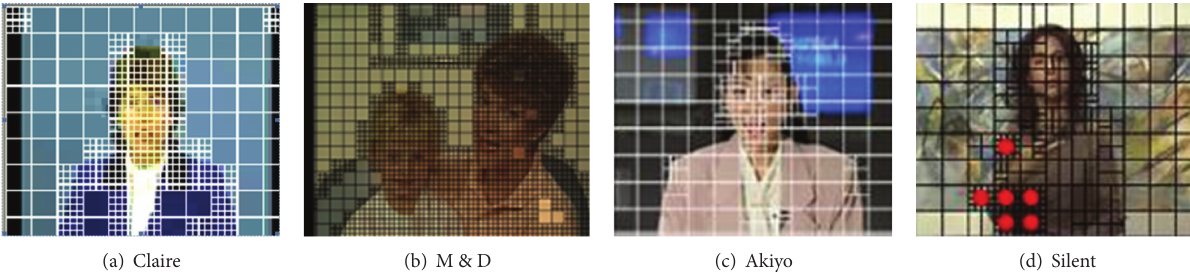
in P-frame coding or uses Intra 4 × 4 in I-frame coding, then the current encoding block has abundance of texture feature or changes in spatial domain, the current block belongs to attention region, the spatial saliency is high, and then it can be expressed as 𝑆(𝑥, 𝑦, Mode ) = 1